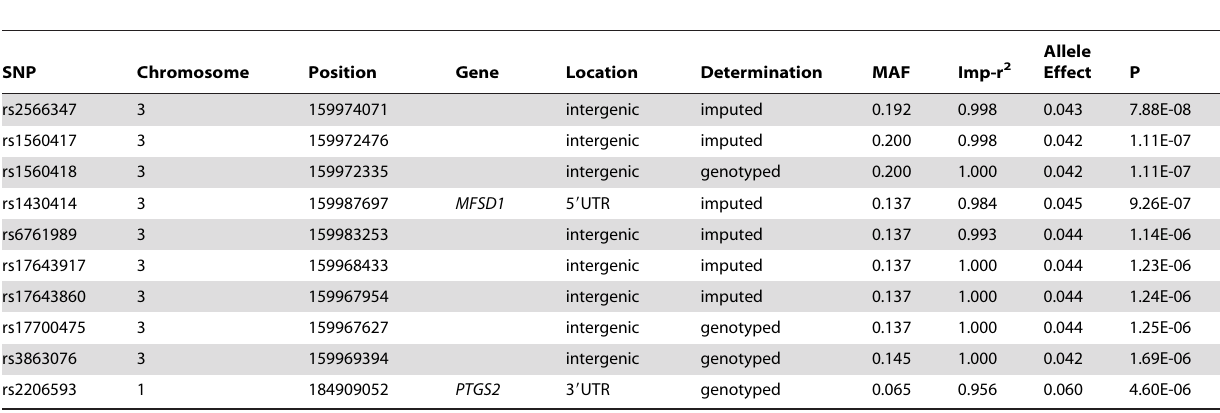
Table 2. The ten most strongly associated SNPs in the GWAS on AAT serum level, conditional on PI S and PI Z alleles in SAPALDIA (N= 1392).